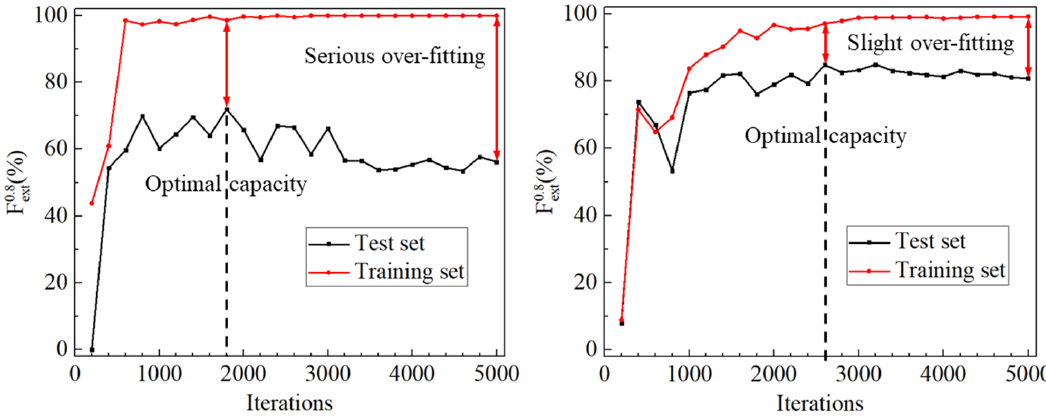
Figure 9. F of the model on the training and test set during the training iterations. The left figure is for training on the original dataset, and the right one is for training on the augmented dataset.